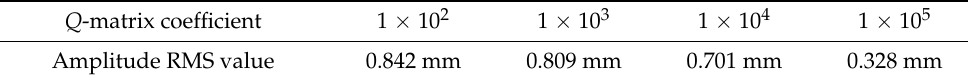
Figure 16. Voltage contrast required for control when R-matrix coefficient is different. ( a ) Required voltage under pulse excitation; ( b ) voltage required under sine wave. Table 6. System response parameters under sine